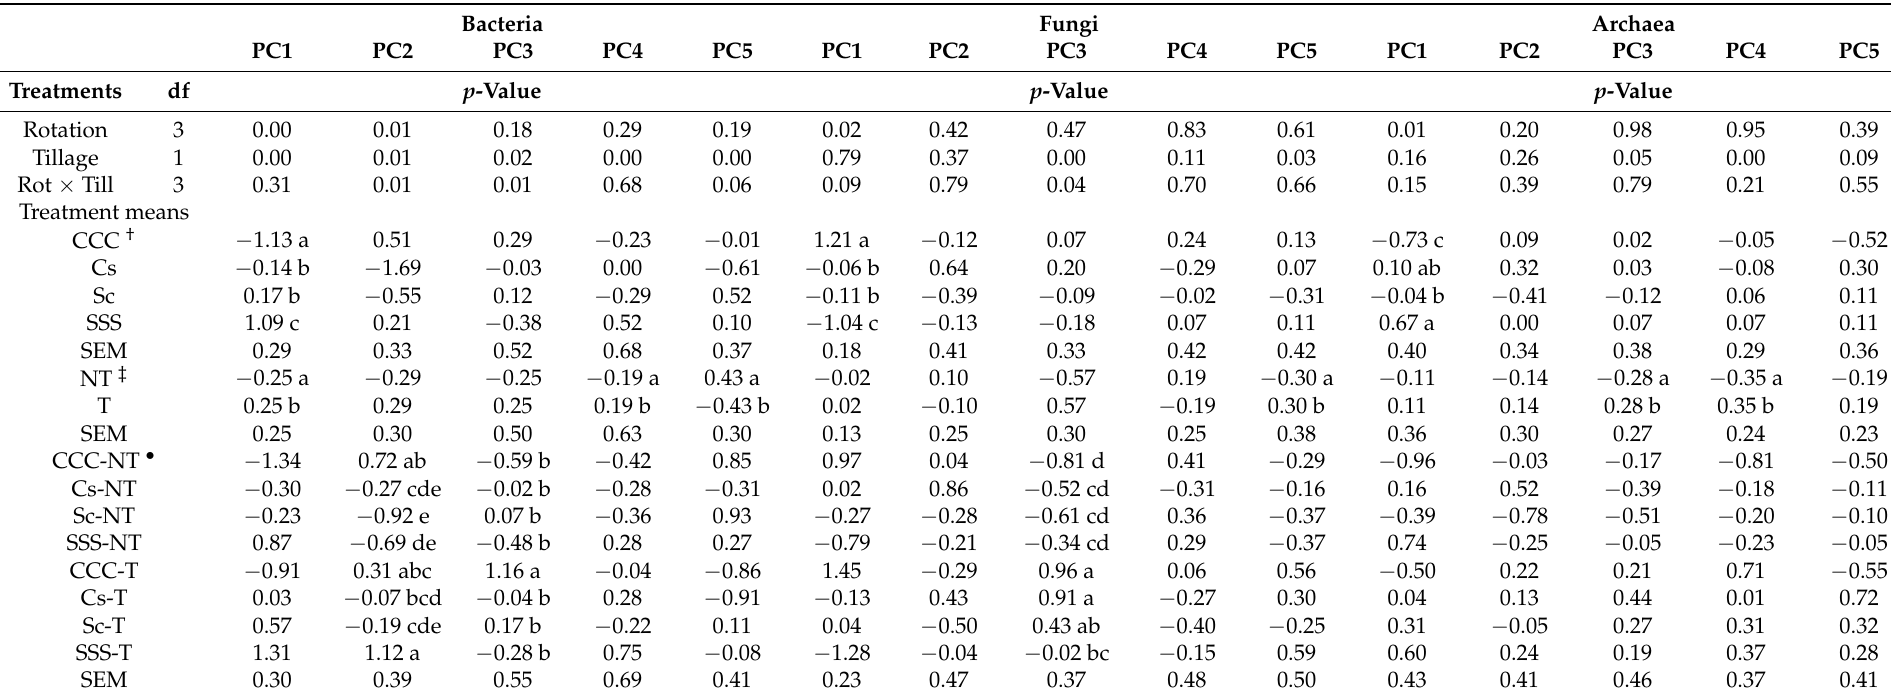
Table 5. Analysis of variance (ANOVA) results for the effects of crop rotation, tillage, and their interaction (Rot × Till) on each group of principal components (PCs) calculated for bacteria, fungi, and archaea taxa datasets. The datasets for each taxa were comprised of indicator ASVs. The probability values ( p -Value) for each treatment effect and degrees of freedom (df) are displayed in the top rows. The treatment mean values and their standard errors (SEM) are presented below. For each taxon group and within a given column, treatment mean values followed by the same lowercase letter were not statistically different ( α =